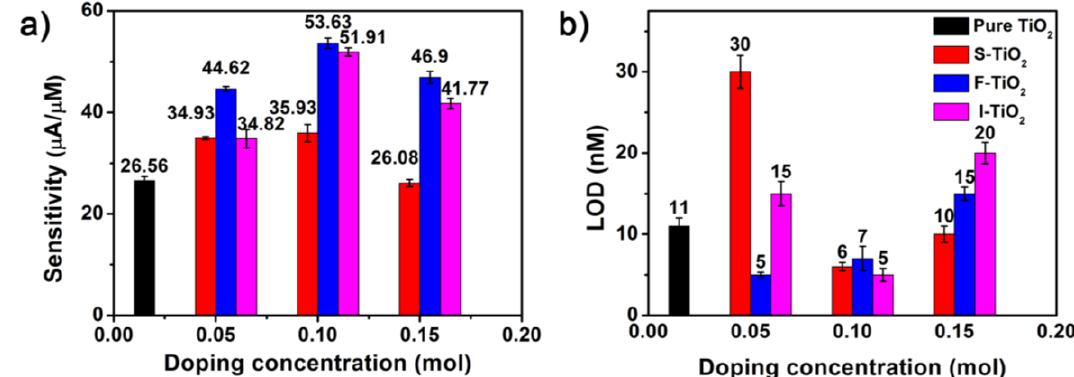
Figure 5. Comparison of ( a ) sensitivity and ( b ) limit of detection for SWASV detection of Pb(II) by pure TiO 2 , sulfur-, fluorine-, and iodine-doped TiO 2 modified GCEs, respectively.